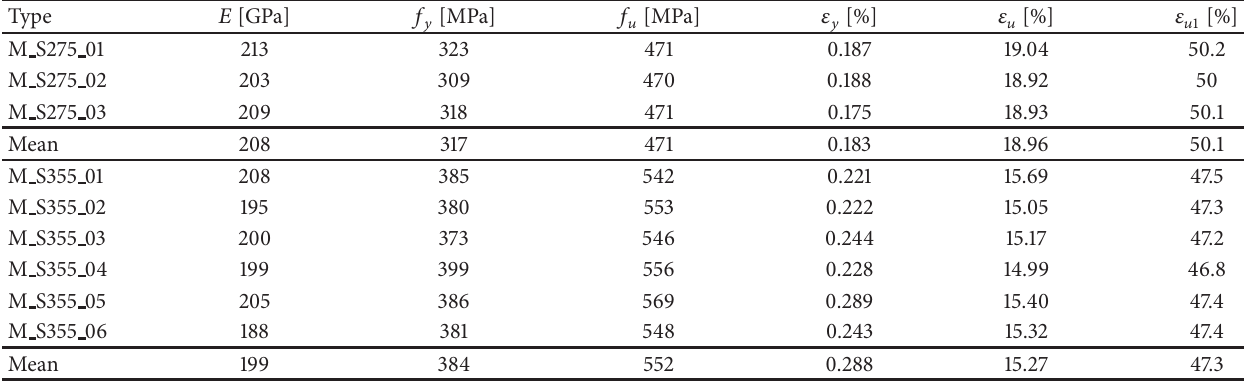
Table 2: Main mechanical properties of specimens for S275 and S355 obtained by monotonic